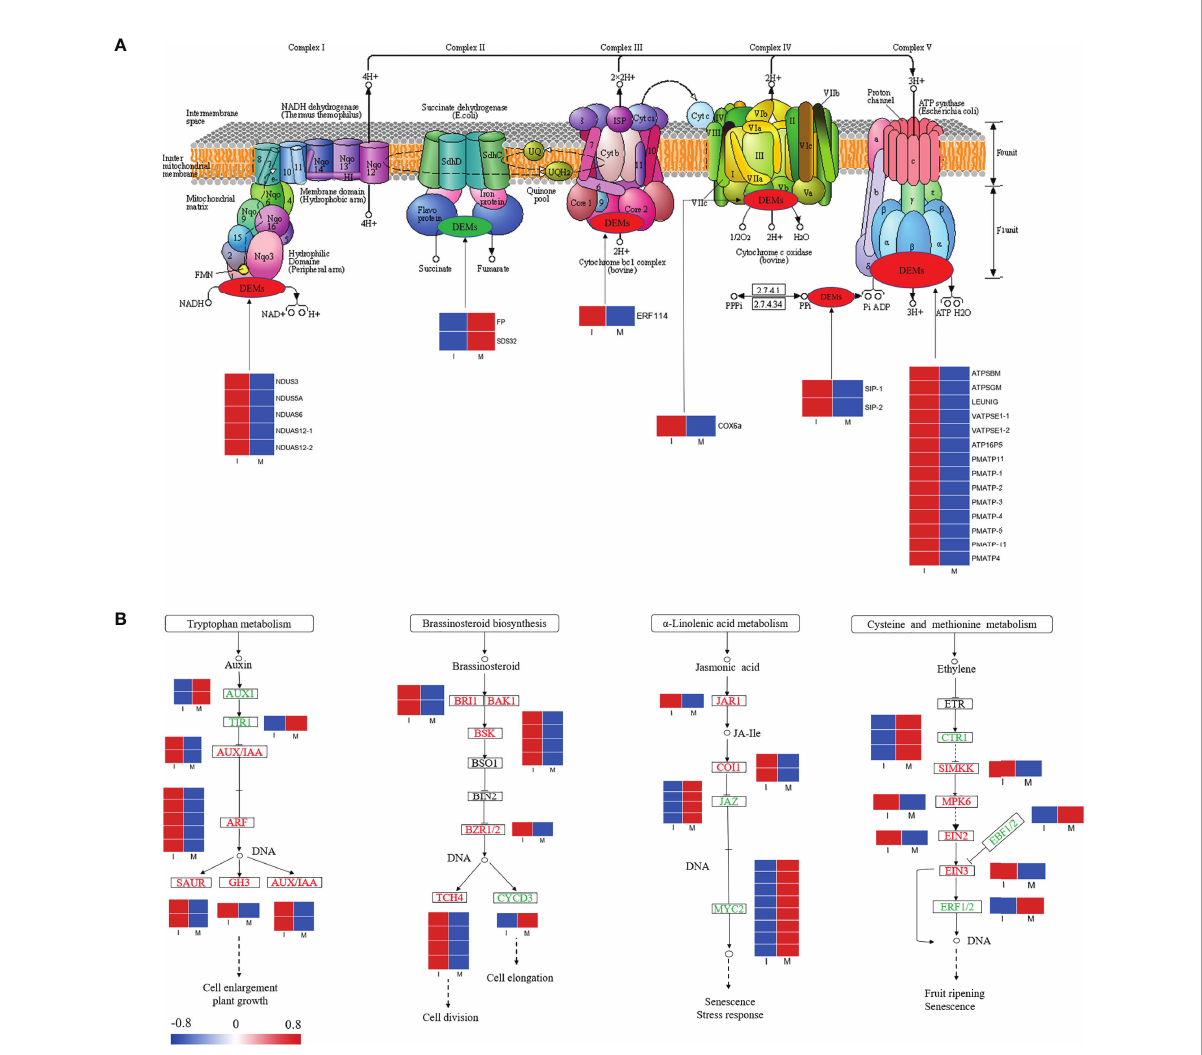
FIGURE 5 Expression pro fi les of DEGs in the oxidative phosphorylation pathway (A) and partial plant hormone signal transduction pathway (B) . Red color denoted genes with high expression level, while blue color denoted genes with low expression level. The relative expression levels of DEGs were calculated using log 2